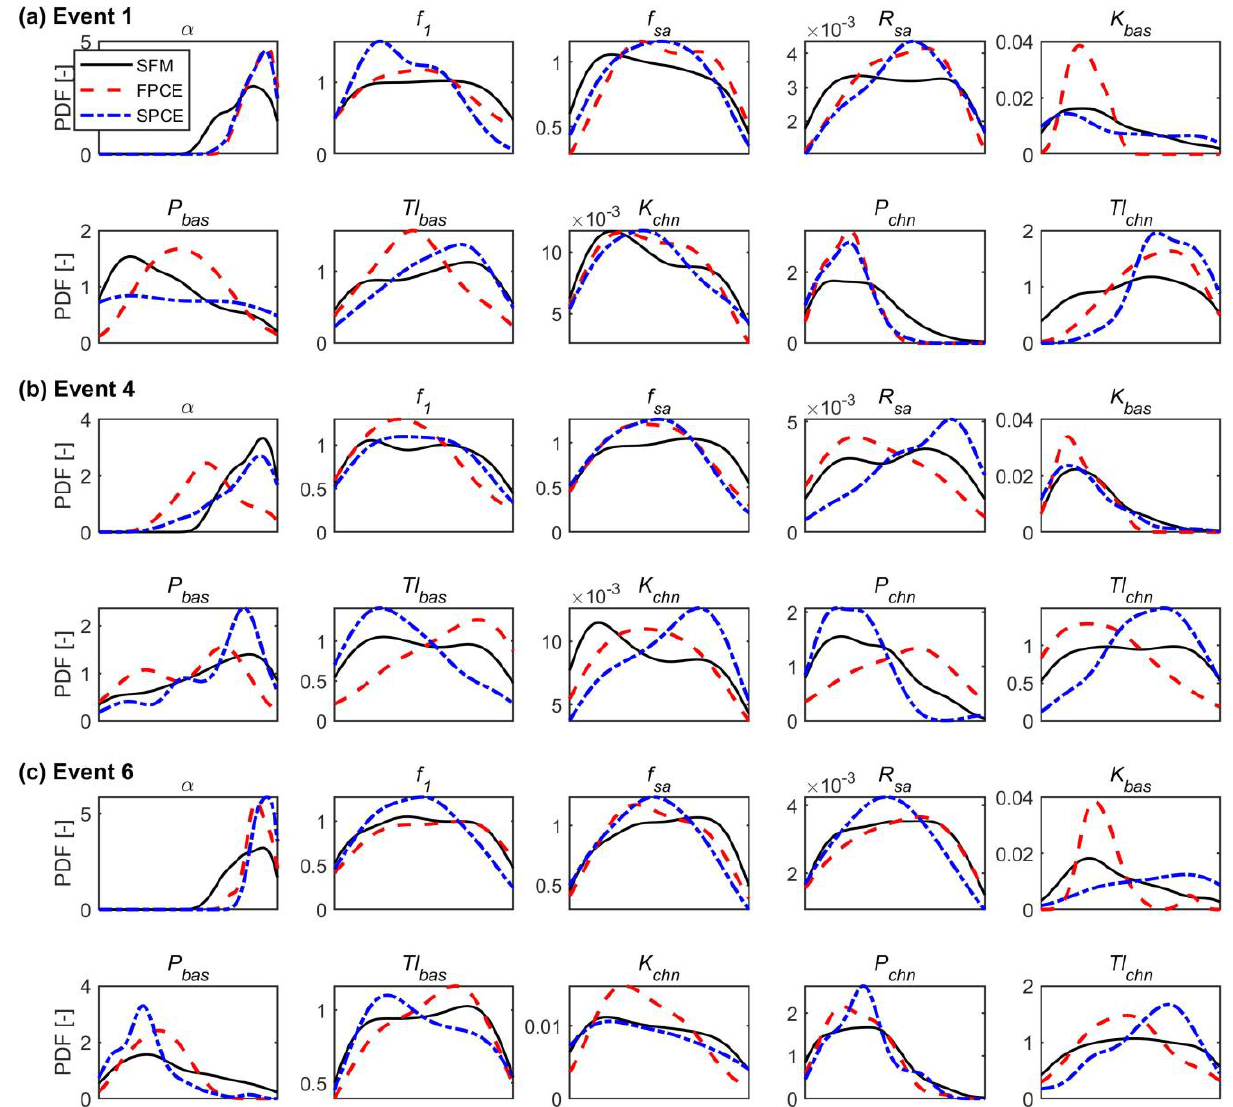
Figure 7. Posterior distributions of 10 model parameters for three streamflow events (( a ) Event 1, ( b ) Event 4, ( c ) Event 6). In each subplot, probability density functions (PDFs) are drawn by using the kernel density estimation for the 1000 behavior parameters obtained through GLUE. The range on the x-axis matches the original range values for each parameter presented in Table 2. Results for high, medium, and low return periods are only demonstrated for simplicity.